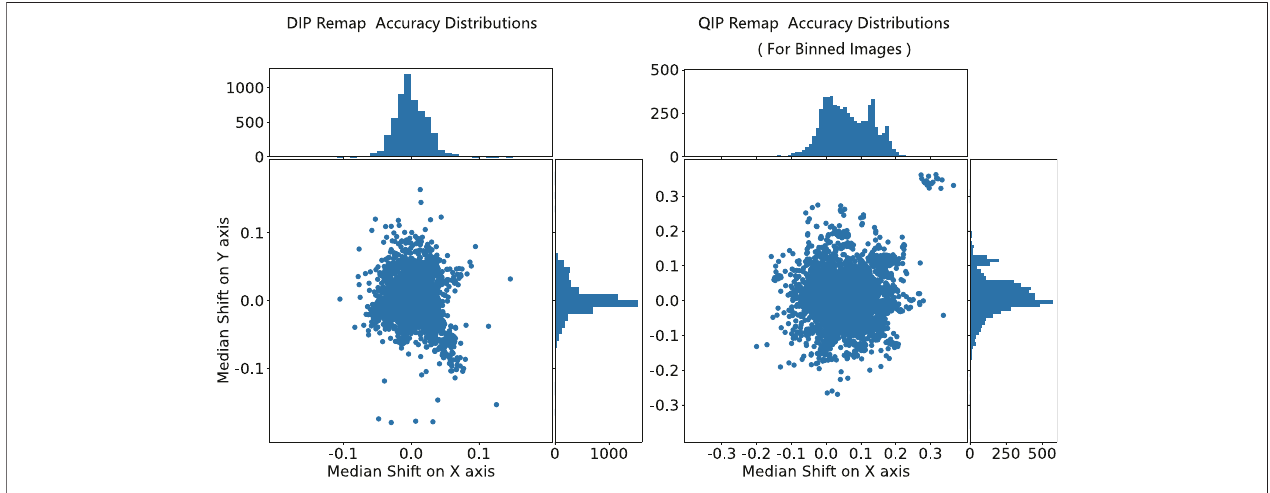
FIGURE 7 | Two panels show the standard deviation of the x and y position differences in matched stars between the reference and remapped images. The right panel shows the unbinned images ’ remap accuracy, and the left panel shows the remap accuracy for QIP.